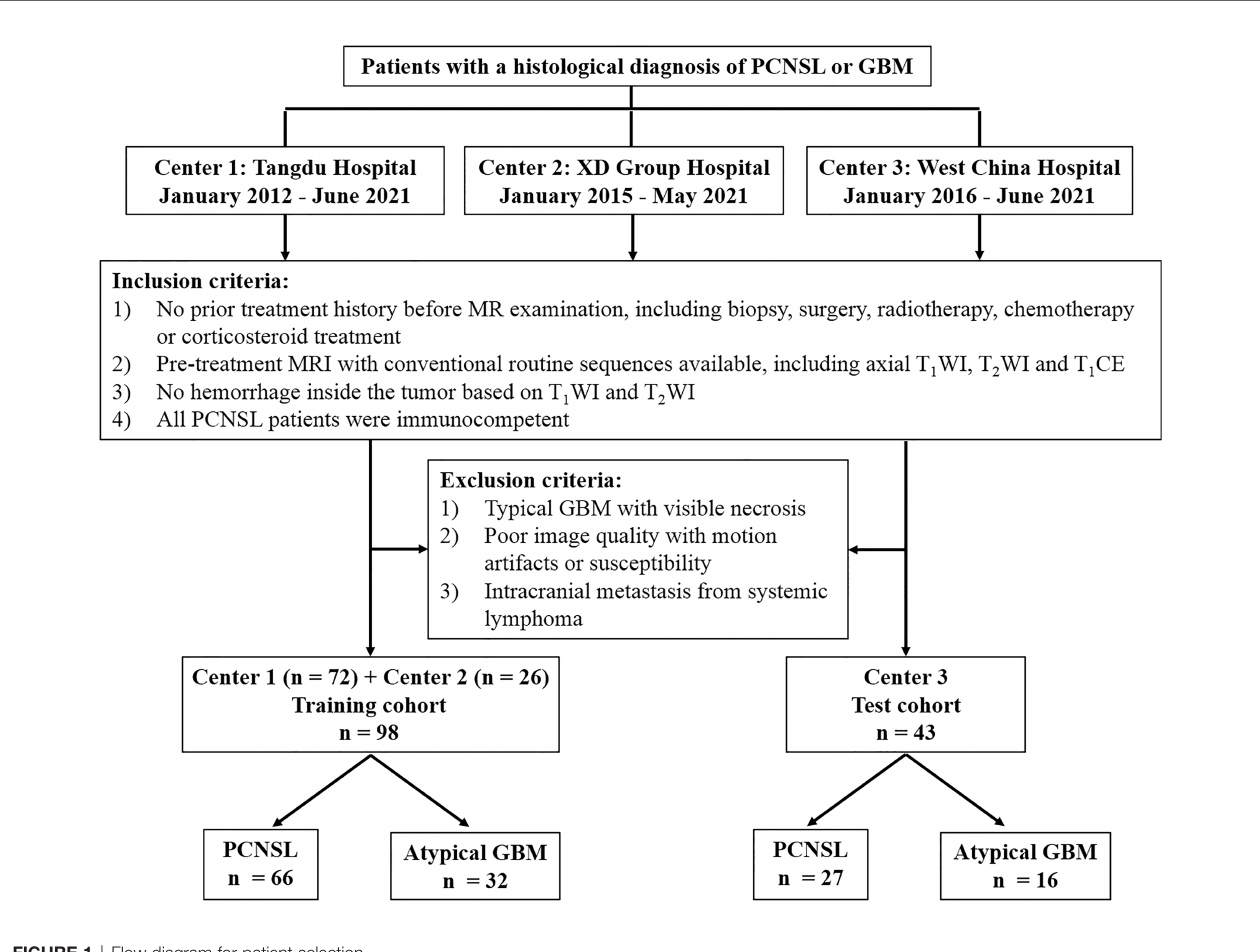
FIGURE 1 | Flow diagram for patient